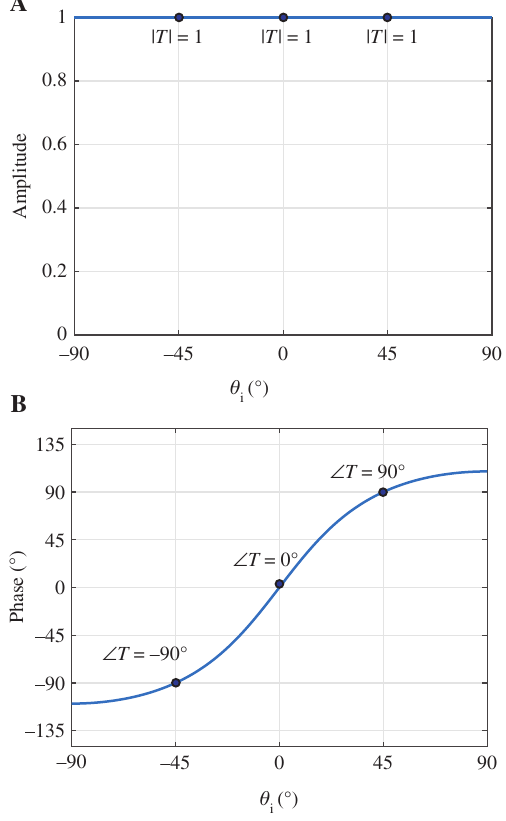
Figure 7: Transmission amplitude (A) and phase (B) as functions of the incidence angle for a metasurface synthesize for the trans- mission coefficients T = { e − j 90 ° ;1; e j 90 ° } (and R = 0) at the